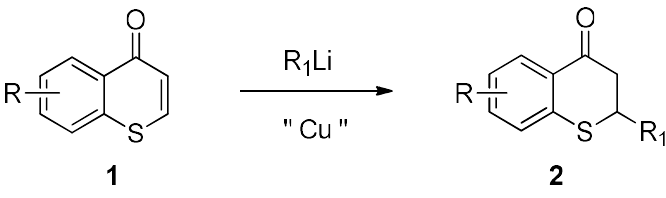
Figure 1. Conjugate Addition of Lithium Dialkylcuprates to Thiochromones.